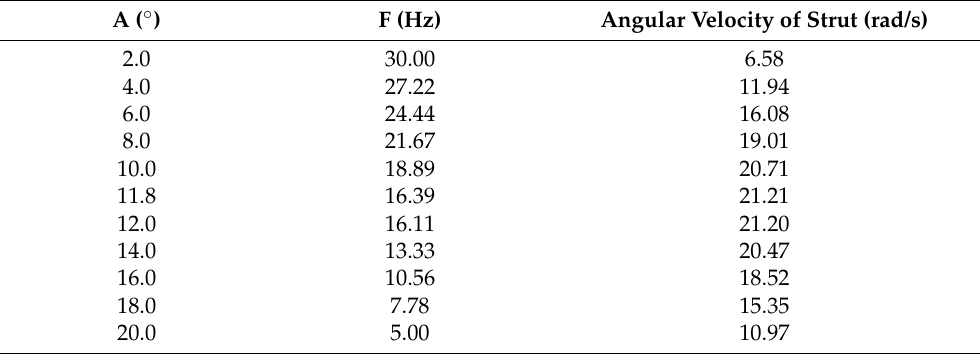
Table 1. Motion parameters of shimmy.